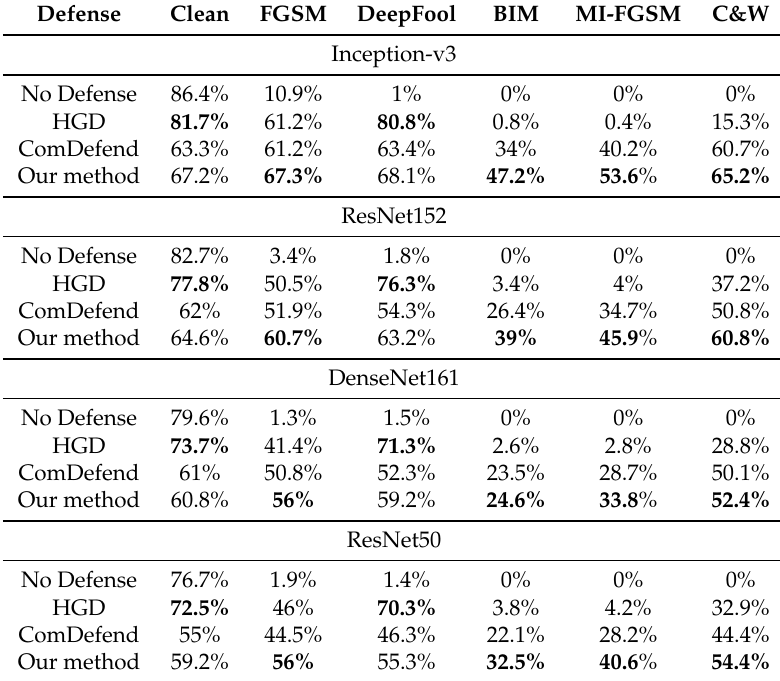
Bold: represents the highest defense success